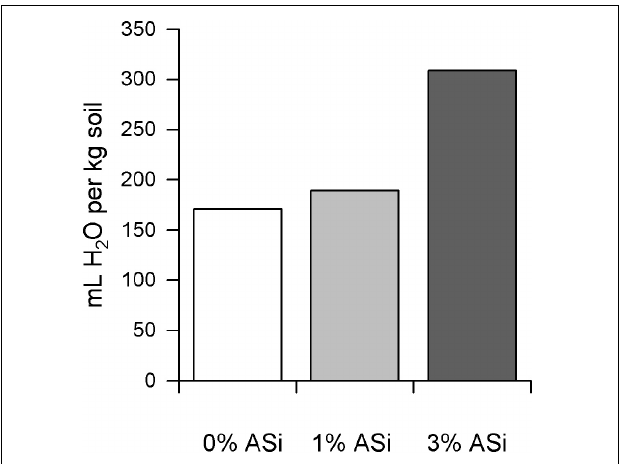
FIGURE 3 | Soil water storage capacity affected by ASi